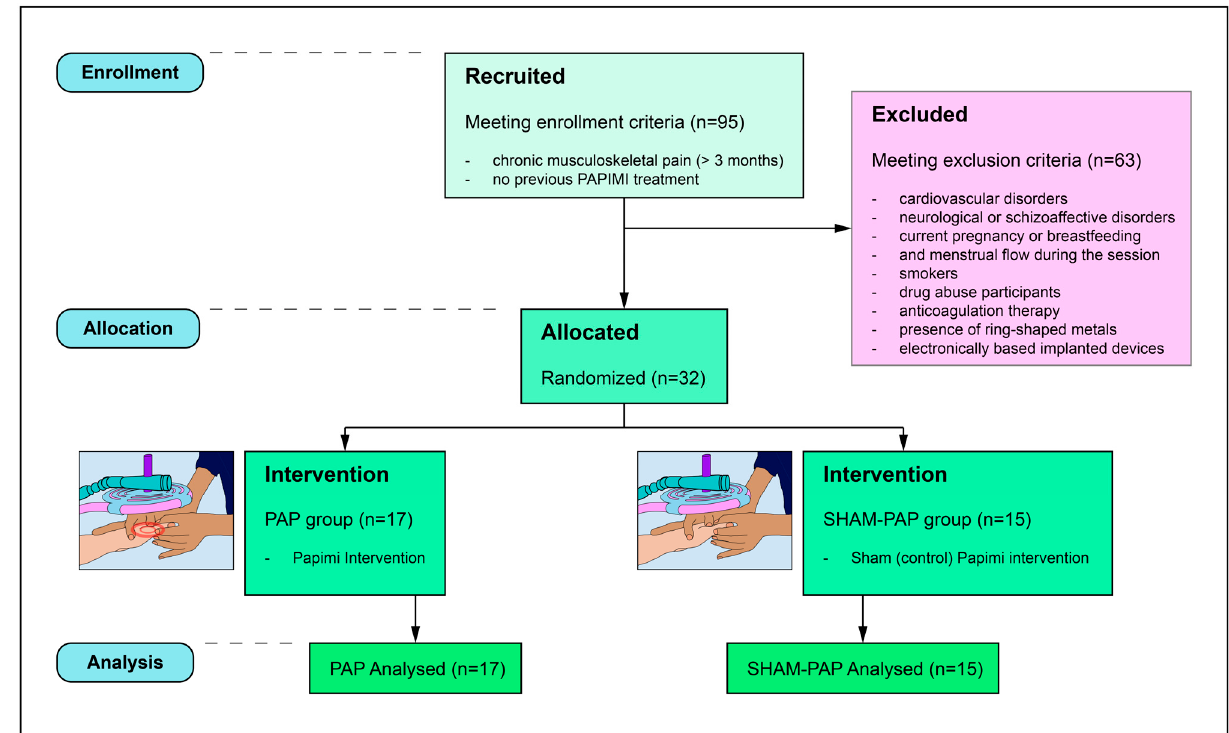
Figure 1. Flow-chart of the study. Sport.